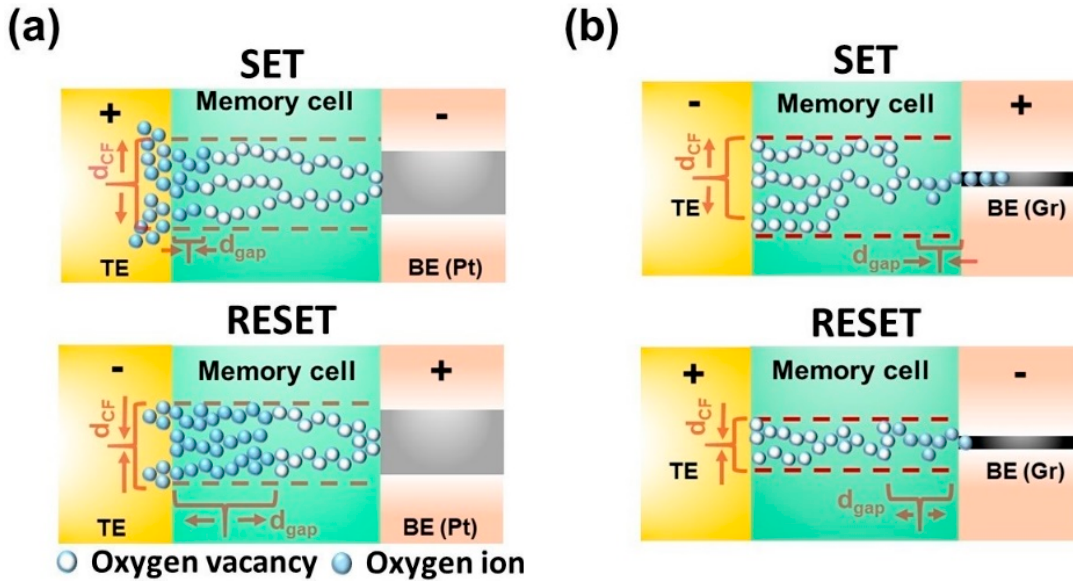
Figure 5. The illustration of the modeling of conductive filament evolution during SET/RESET programming operations in the VRRAM with ( a ) Pt and ( b ) graphene edge electrodes.